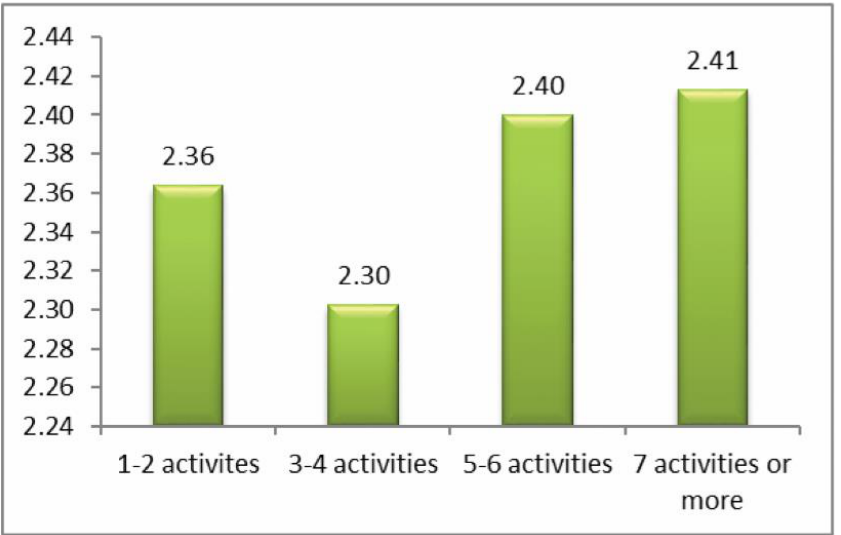
Figure 8. The risk of being a cybervictim (4-point scale), by number of activities on the internet for the adolescents who were cyberbullied ( n = 163).